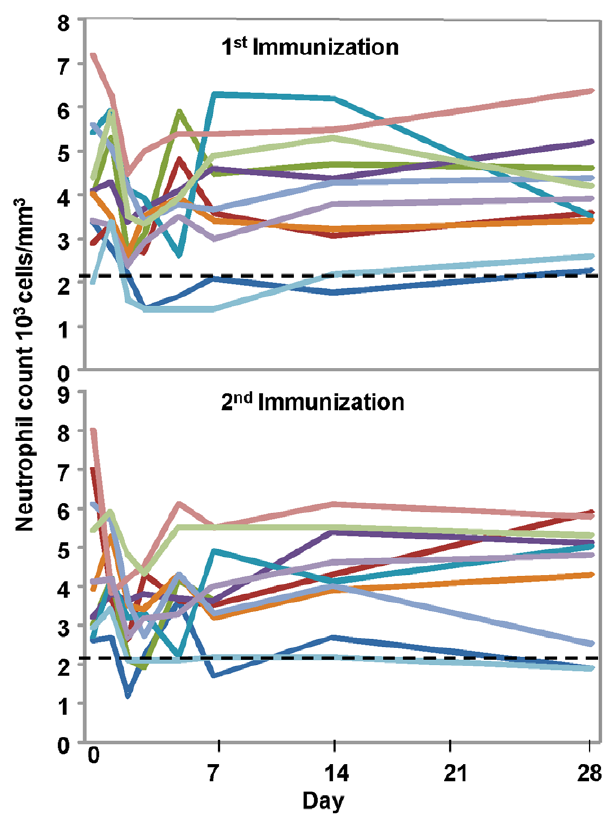
Figure 3. Neutrophil Kinetics Group 3. A fall in neutrophil count was observed in most volunteers at 2–3 days post-immunization with return to normal or near normal levels by day 7 post-immunization after the 1st and 2nd immunization. Day 0 for the 2nd immunization is 15 weeks after the 1st immunization. Dotted line indicates normal levels.